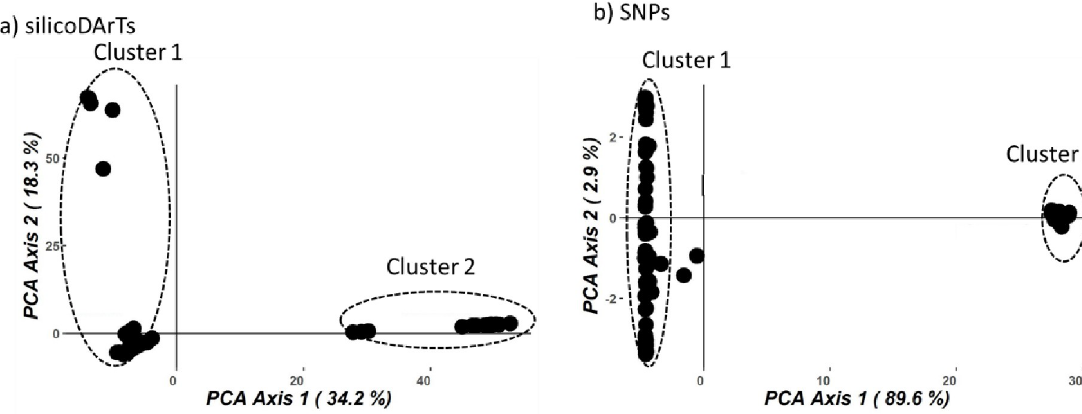
Fig 4. Principal coordinates analysis plot to infer group structure of T . orientalis based on a) silicoDArT b) SNP markers. Axis explained respectively 34.2% and 89.6% of the total variation in the samples based on respectively silicoDArT and SNP markers.